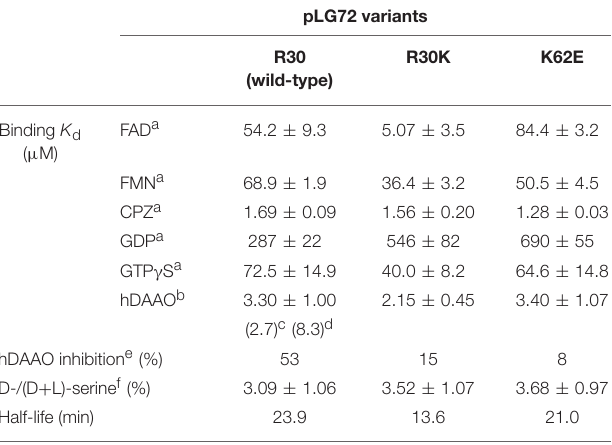
TABLE 1 | Properties of pLG72 variants (Sacchi et al.,